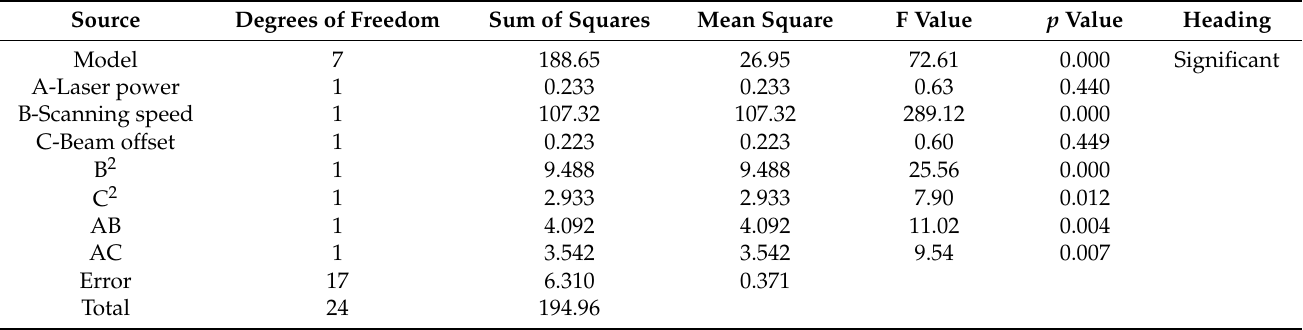
Table 9. Analysis of variance for response surface